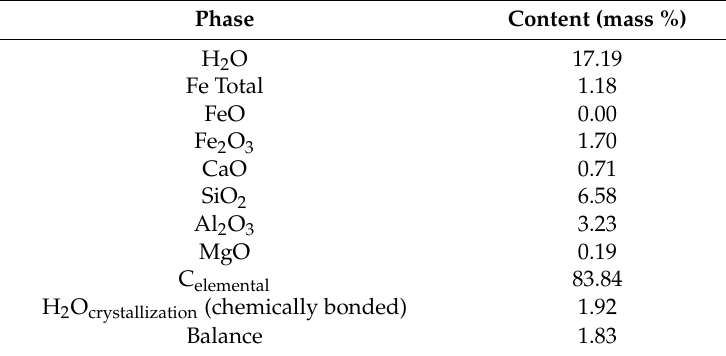
Table 2. Chemical composition of the coke breeze.